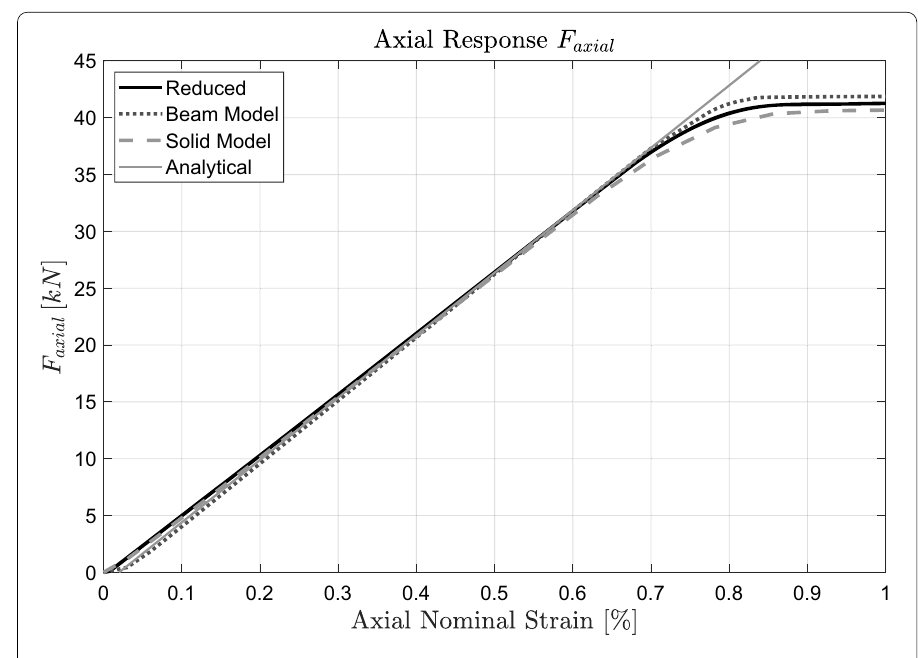
Fig. 3 Axial response of the wire strand 1+6. Geometrical parameters are listed in Table 3 and material properties in Table